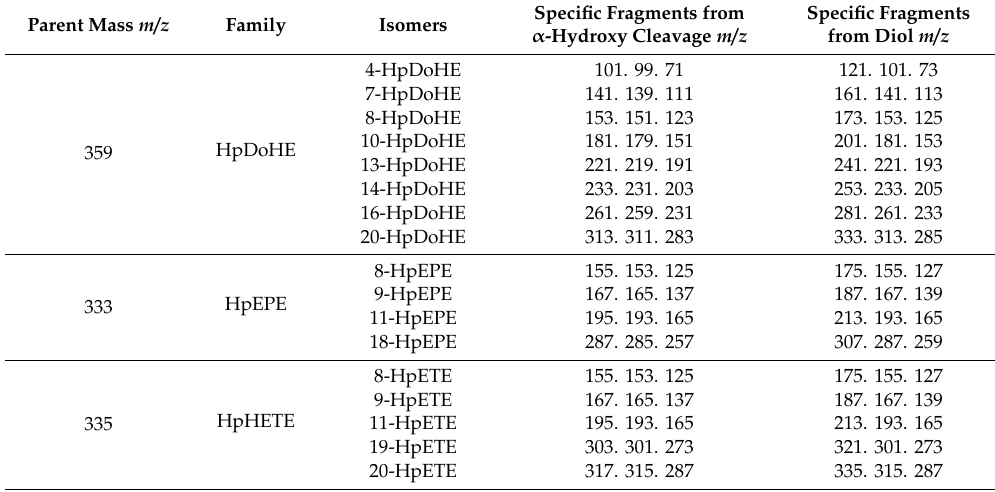
Table 3. Hypothesized specific fragments produced from di ff erent isomers of ARA. EPA and DHA hydroperoxides based on the chain position of –OOH